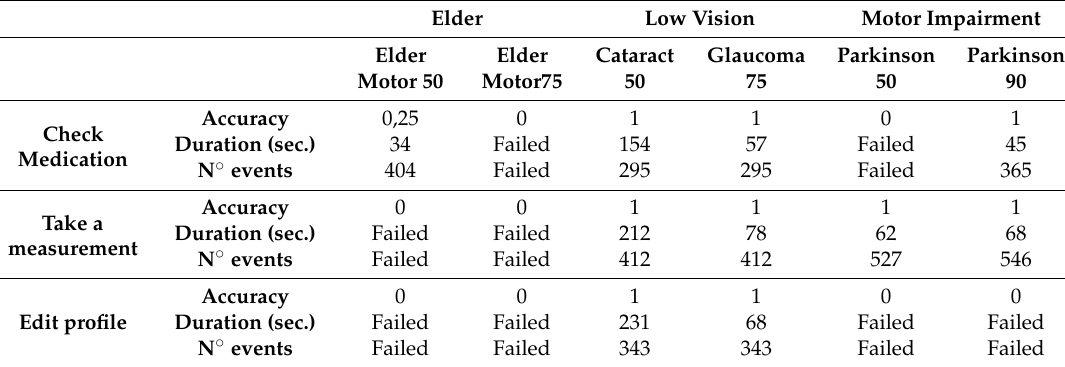
Table 4. Overall results of simulations with Virtual User Models